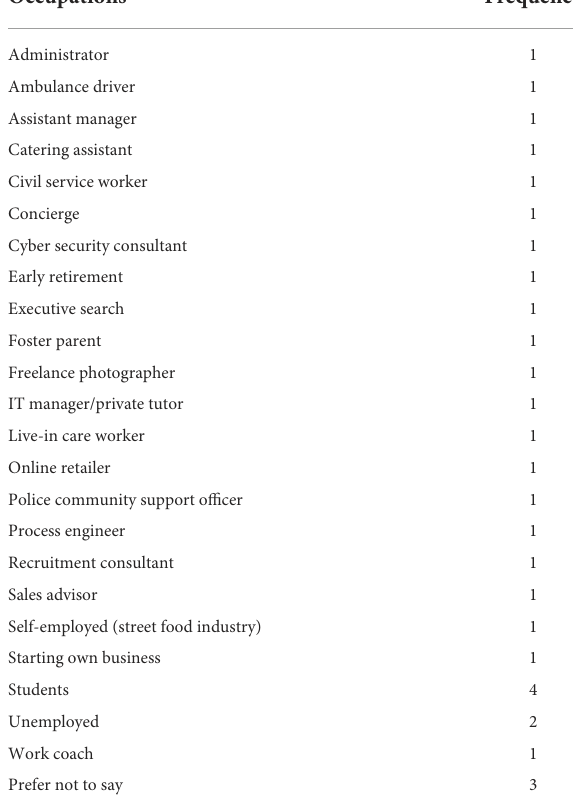
TABLE 2 Demographic information divided by gender and marital status ( n = 30).